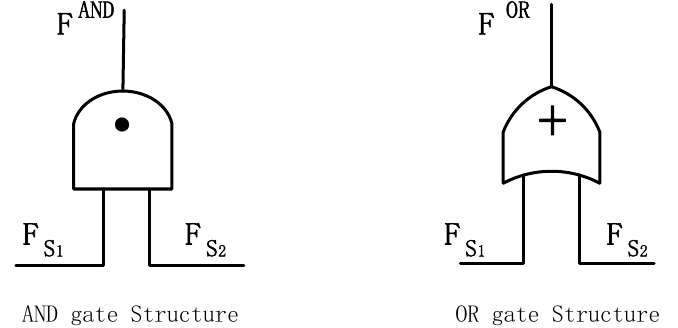
Figure 2. AND gate and OR gate structure chart.